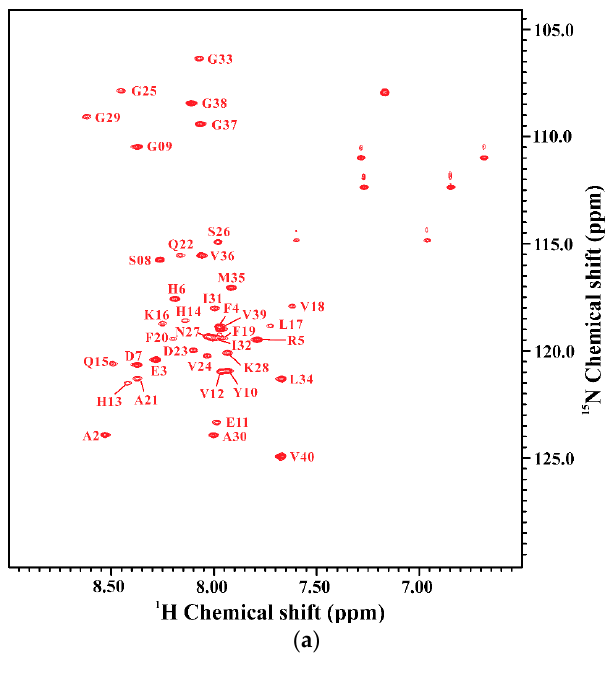
Figure 1. Overlay of CD spectra of wild-type A β 40 ( black ), A β 40 (E22Q) ( red )